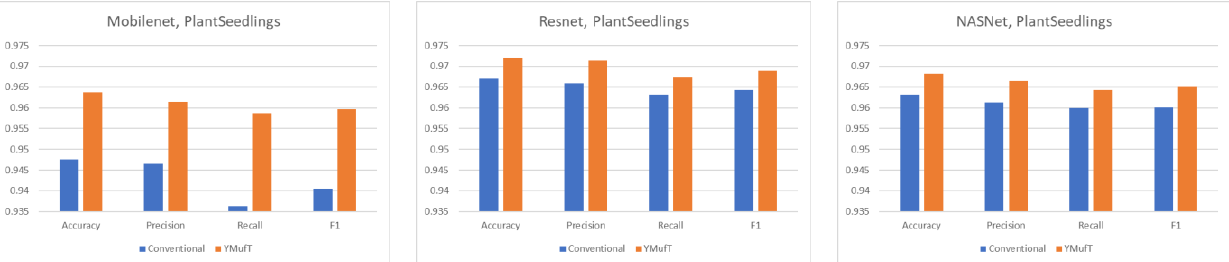
Figure 21. Average overall performance of 5-fold cross-validation on the PlantSeedlings dataset.